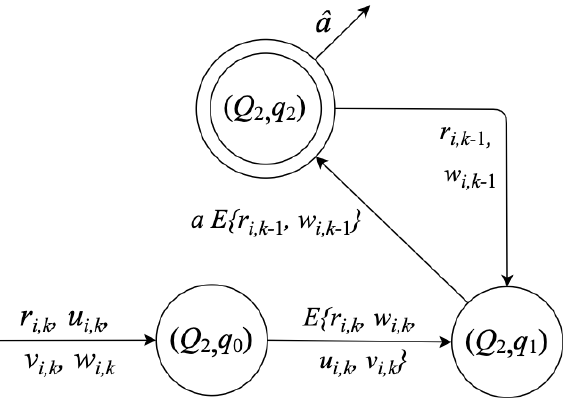
Figure 6. States diagram Q 2 for the parameter estimation ˆ a i , k